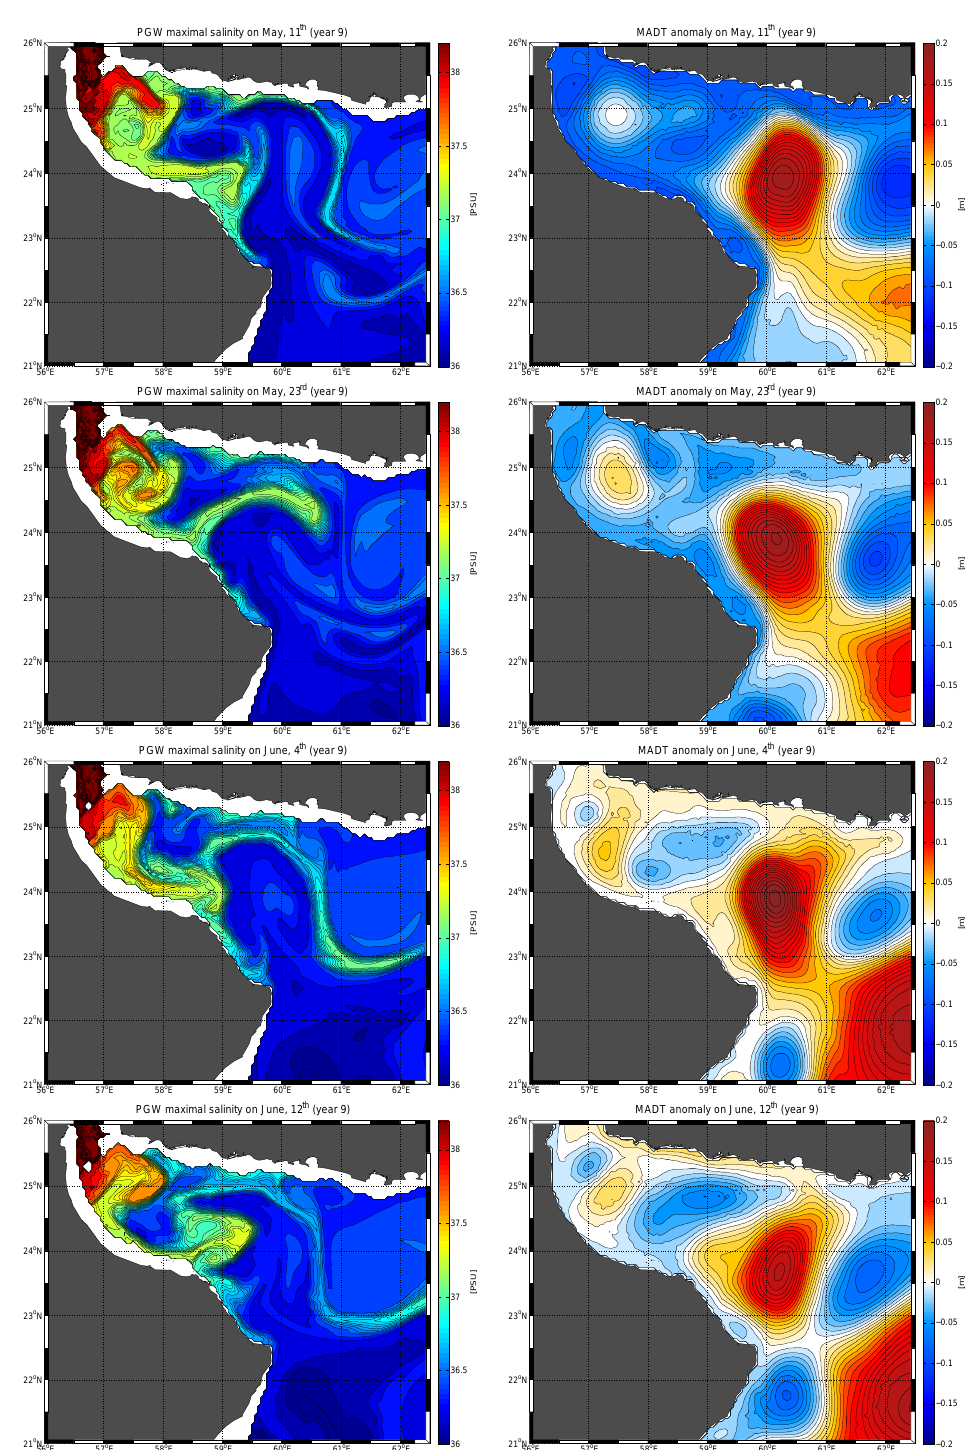
Figure 21. Evolution of the maximal PGW salinity (left) and MADT anomaly (right) during an ejection of PGW off Ra’s Al Hamra in year 9 of the HYCOM simulation, on 11 May (first row), 23 May (second row), 4 June (third row) and 12 June (fourth